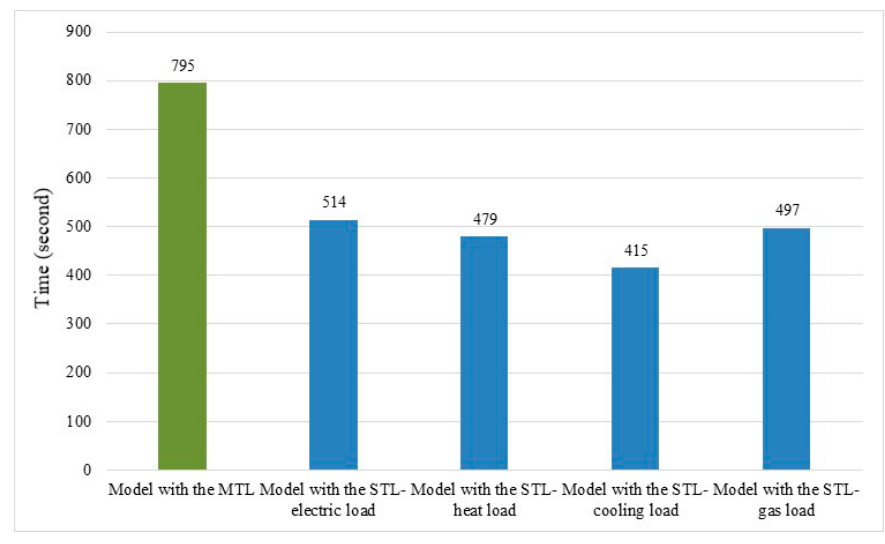
Figure 15. Comparison of calculation time of different learning